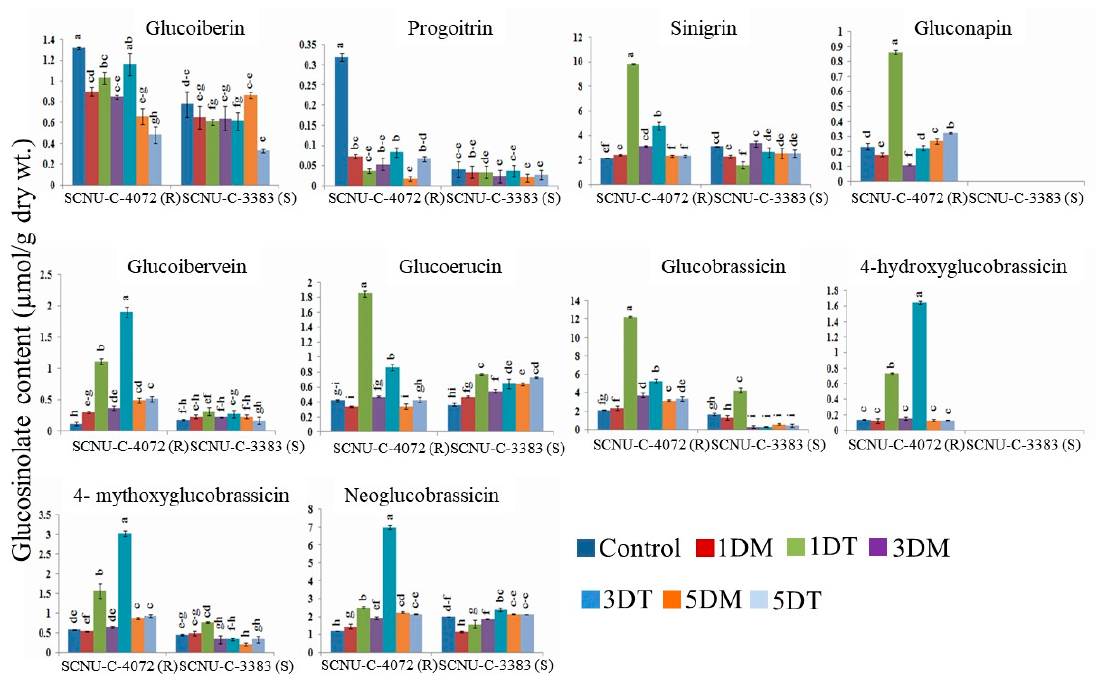
Figure 3. Glucosinolate contents of cabbage leaf samples from black rot resistant (SCNU-C-4072) and susceptible (SCNU-C-3383) lines under different treatments (C, control; 1DM, 1 day mock; 1DT, 1 day